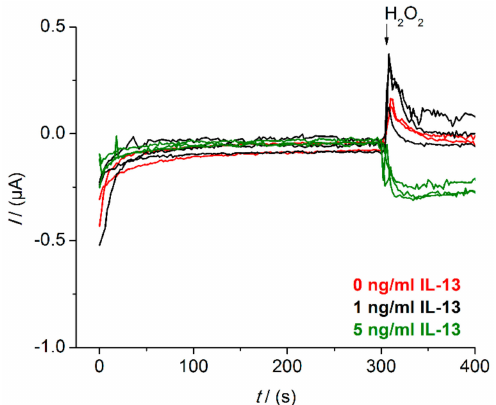
Figure A3. Raw data signals of IL-13 immunosensor measured in the beaker. Amperometric measurements performed at 0.0 V. Triplicates of sensors with 5.0 ng/mL of IL-13 ( green ) and with 1.0 ng/mL of IL-13 ( black ) prepared. Duplicates of sensor with 0.0 ng/mL of IL-13 ( red ) prepared. Measurements in 10 mL of 1 mM hydroquinone in 0.1 M PBS pH 6.0 after addition of 100 µ L of 50 mM hydrogen peroxide in 0.1 M PBS pH